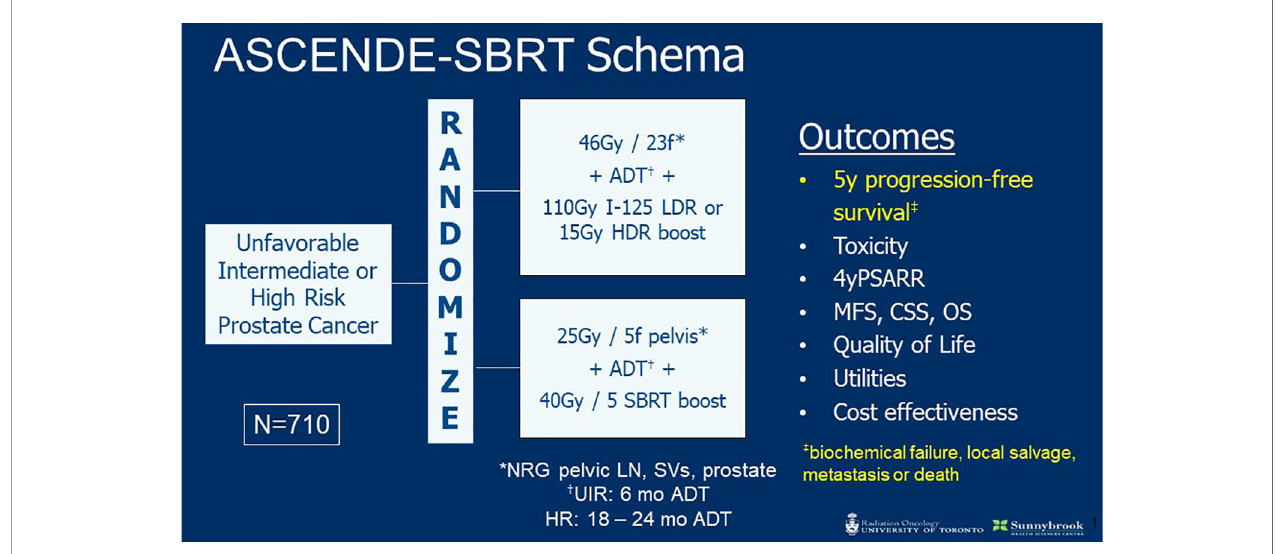
FIGURE 1 | ASCENDE-SBRT Trial